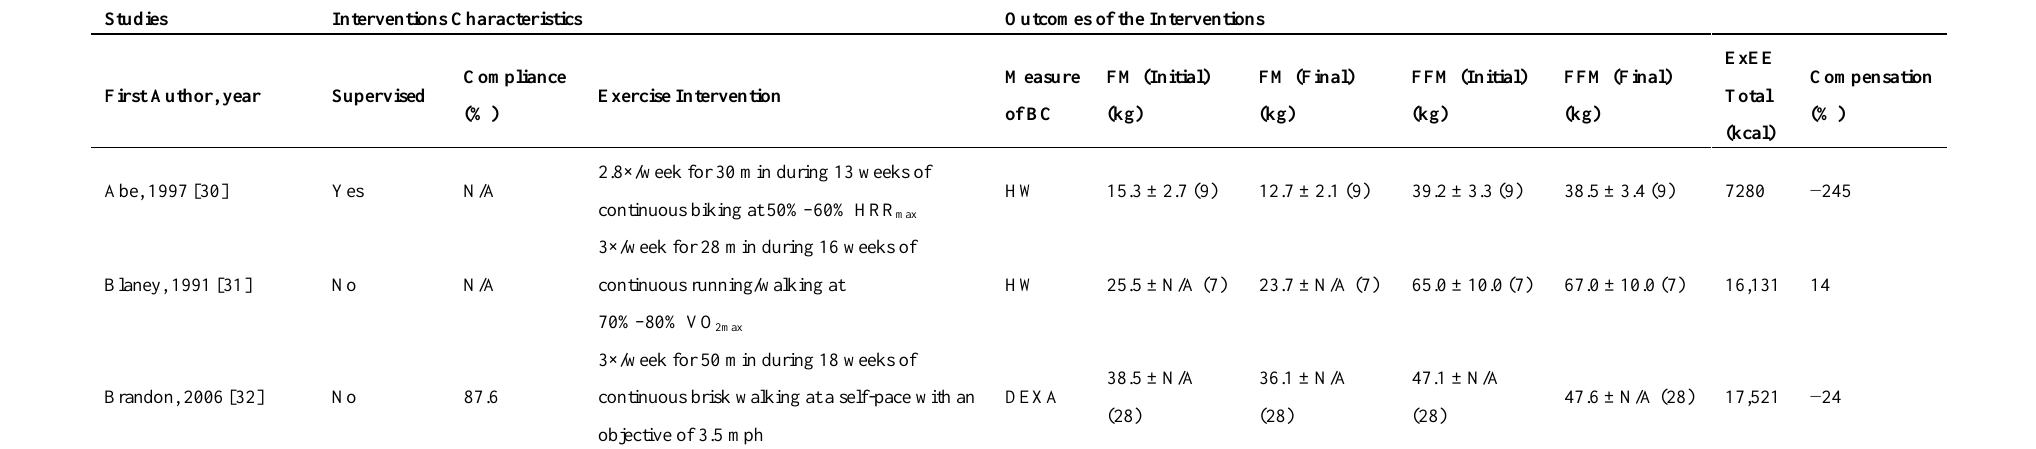
Table 3. Characteristics of the intervention and the outcomes ( n = 61). ExEE, exercise